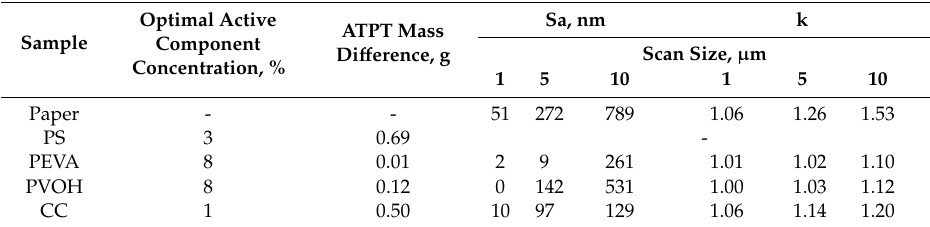
Figure 1. The contact angle dependence on the mass fraction of applied active component in the pre-coating layer blend. Pre-coating blend concentrations were as follows: 0.2 to 3% for PS, 0.2 to 9% for PEVA emulsion, 0.2 to 9.5% for PVOH solution, and 0.2 to 2% for CC solution. Table 1. Optimal active component concentrations for different types of pre-coating layer blends; adhesive tape peel test (ATPT) mass difference and surface morphology parameters for the paper samples with and without pre-coating layers. Sa—surface roughness, k—smoothness coefficient.